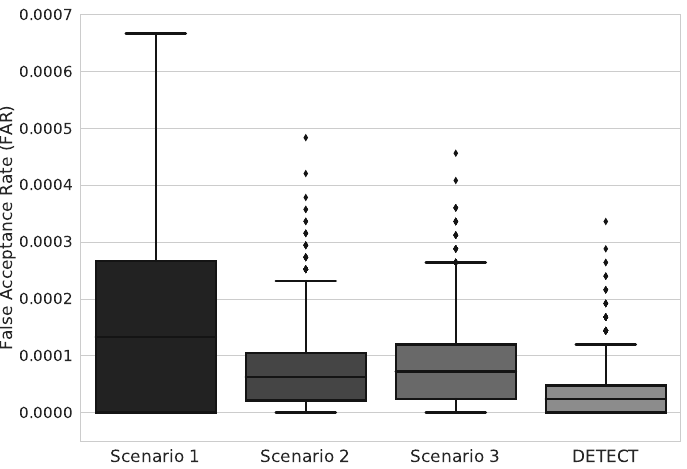
Figure 5. FAR results for each scenario of data improvement models.